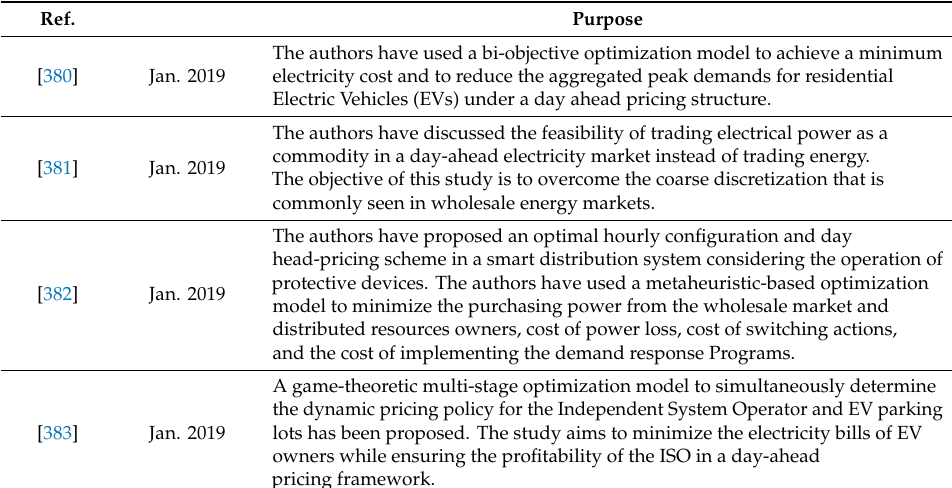
Table 14. Developments in day-ahead pricing